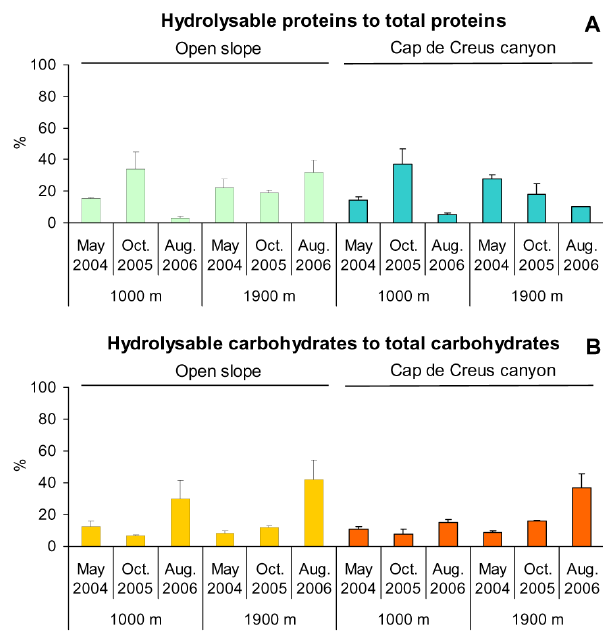
Fig. 3. Spatial patterns of the contribution of (A) enzymatically hy- drolysable proteins and (B) carbohydrates to their respective total pools in surface sediments of the Cap de Creus canyon and adjacent open slope of the Catalan margin collected in the different sampling periods. Standard deviations are